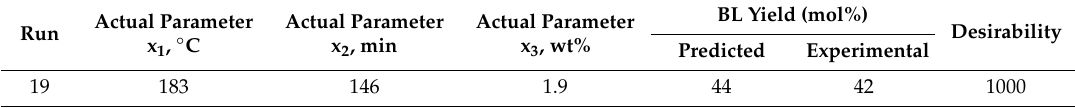
Table 6. Predicted and experimental BL yield: model